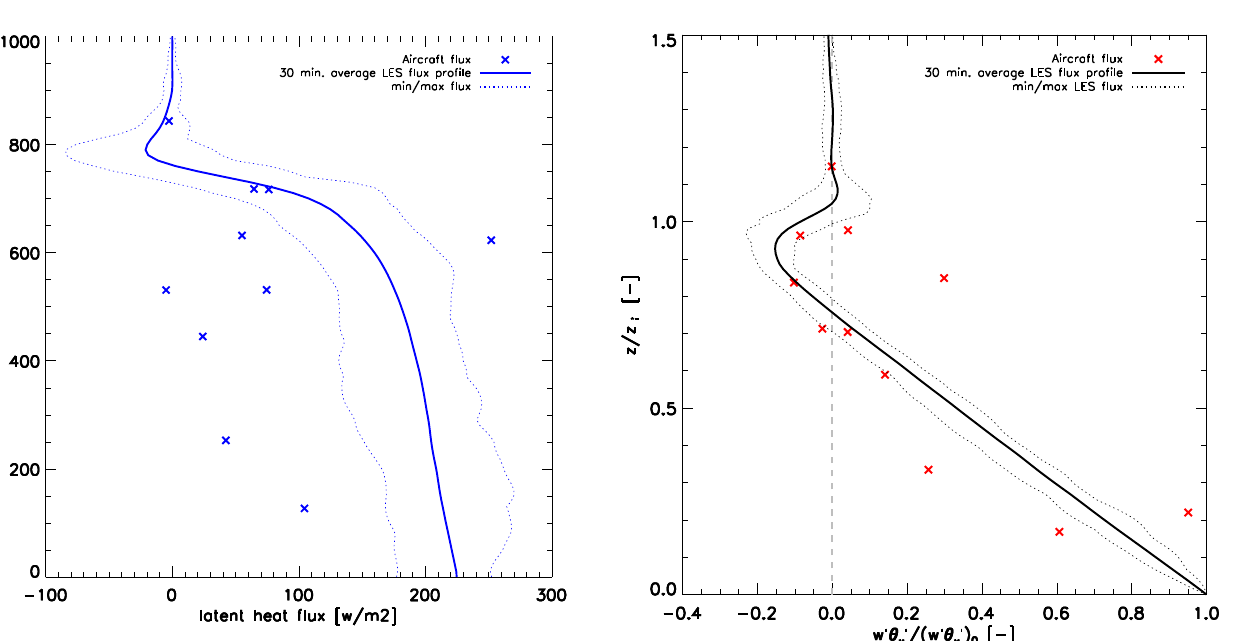
Figure 13. Same as Fig. 11, but now for the non-dimensional buoy- ancy flux and